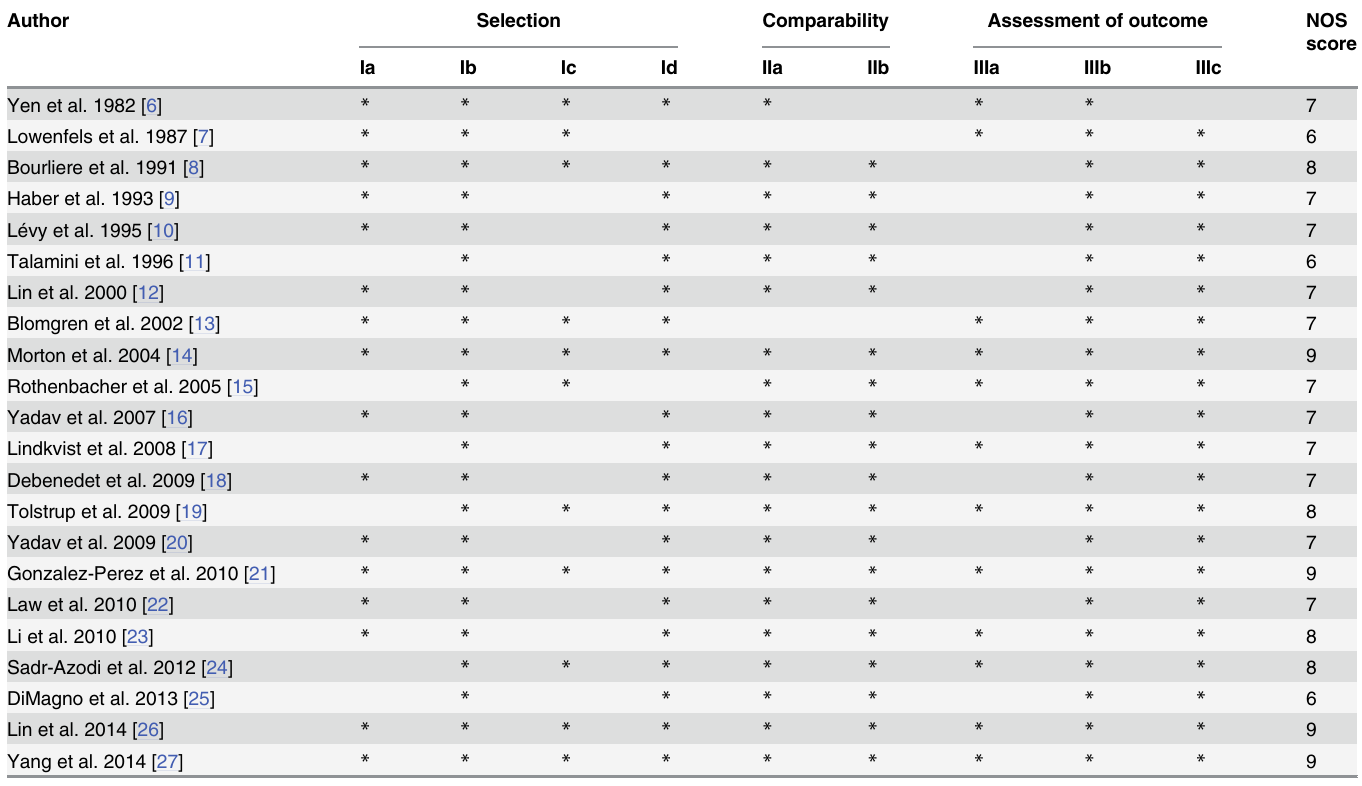
Table 2. Methodological quality of included